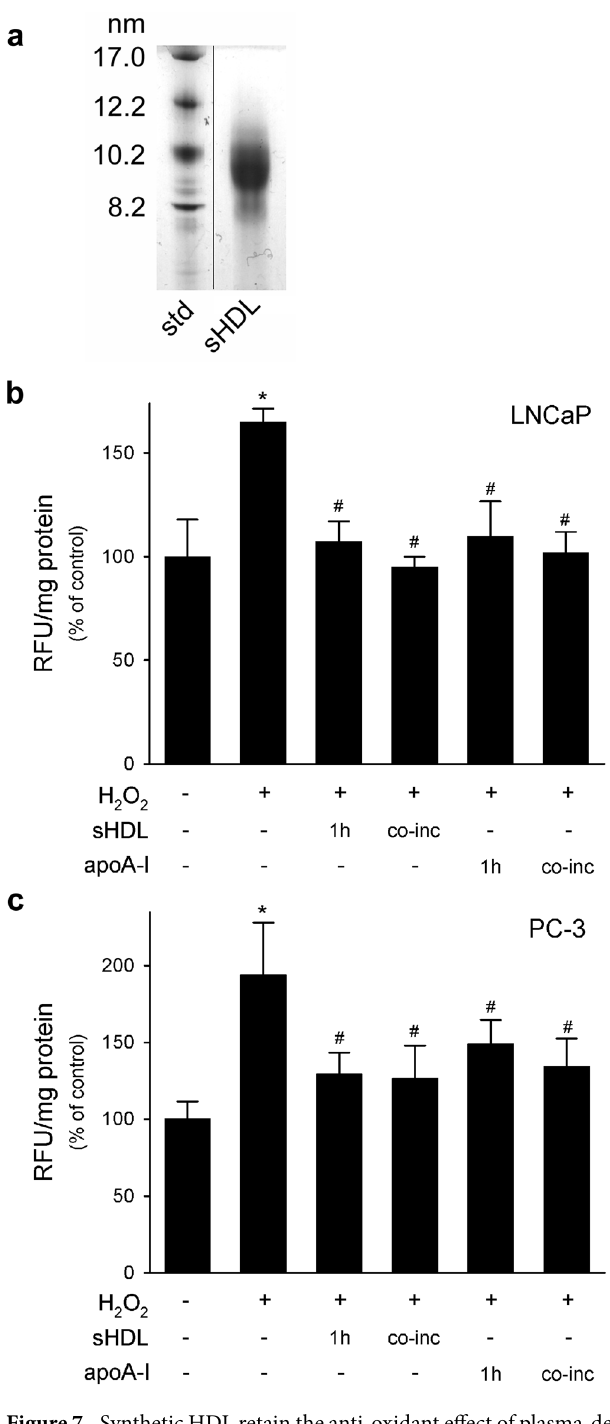
Figure 7. Synthetic HDL retain the anti-oxidant effect of plasma-derived HDL. Panel a, synthetic HDL particle formation and size was verified by native GGE. LNCaP (Panel b) and PC-3 cells (Panel c) were stimulated with 0.5 mM H 2 O 2 for 1 h. sHDL or apoA-I were tested at 0.5 mg/ml as a pre-treatment of 1 h or as co-incubation with H 2 O 2 (co-inc). ROS production was evaluated by fluorescence. Data are expressed as relative fluorescent units (RFU) normalized by the protein concentration of total cell lysate, mean ± SD, n = 4. * P < 0.05 vs control, # P < 0.05 vs H 2 O 2 -stimulated